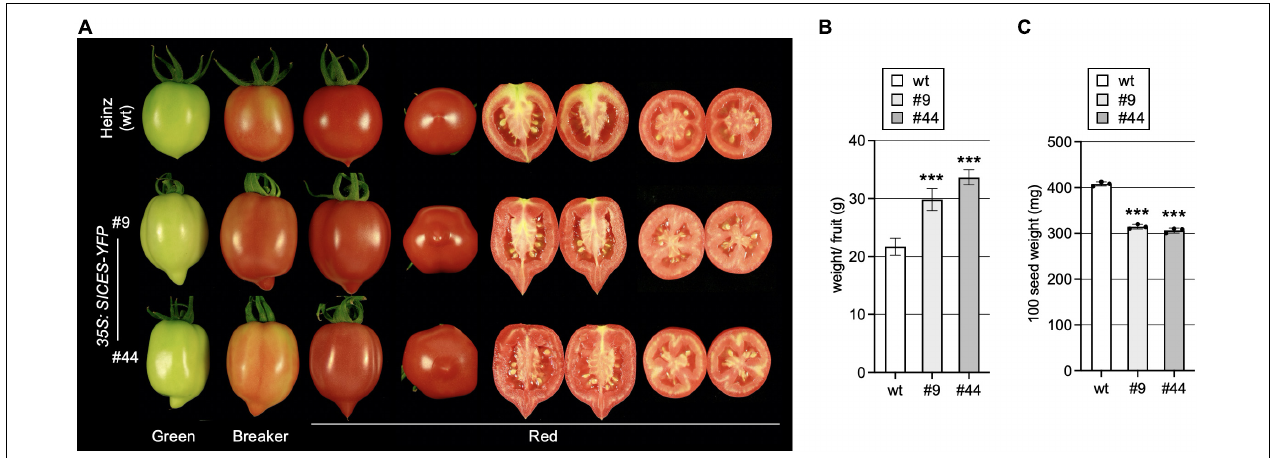
FIGURE 4 | SlCES over-expression alters fruit development. (A) Photos of representative fruits of SlCESoe plants and wild-type at different developmental stages. For red fruits transverse and longitudinal sections are shown. (B) Average fruit weight of fully ripe fruits of SlCESoe plants. 10–15 fully ripe fruits were harvested and weighed to obtain a total weight, which was then divided by the fruit number, to obtain a mean. Data show the mean ± SD of n = 6 (*** P < 0.001; Student’s t -test). (C) Quantification of 100-seed-weight. Seeds were collected from ripe fruits, air-dried and 100 seeds were weighted. Data show the mean ± SD of n = 3 (*** P < 0.001; Student’s t